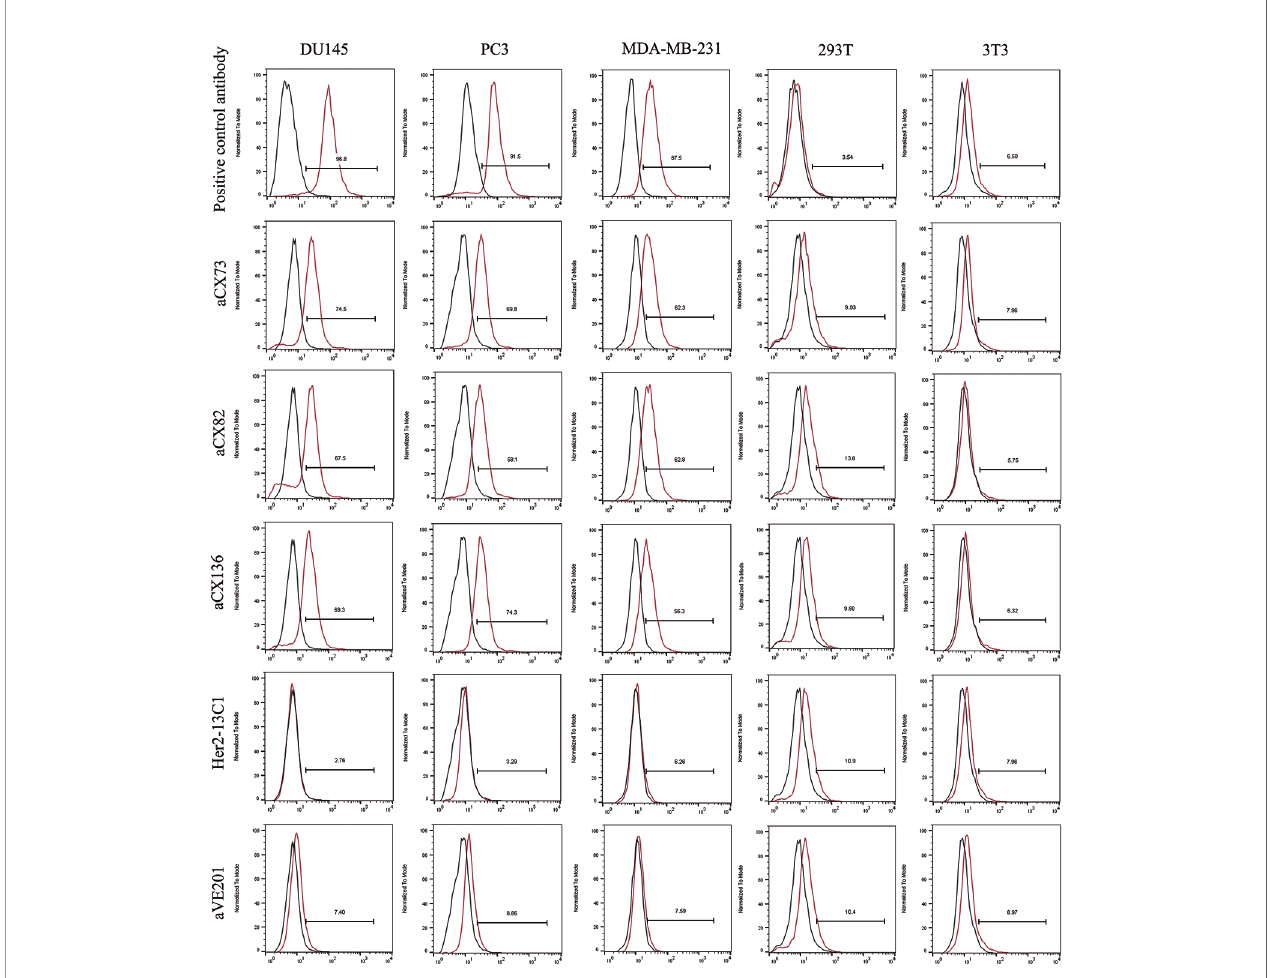
FIGURE 3 | The binding of the three anti-CXCR4 scFvs to cancer cells (DU145, PC3 and MDA-MB-231) was tested by fl ow cytometry. 293T and 3T3 cells were tested as controls. Binding of an isotype control antibody or no antibody control was shown as black curves. Binding of the three anti-CXCR4 scFvs, anti-CXCR4 positive control antibody or the negative control antibodies (Her2-13C1 and aVE201) was shown as red